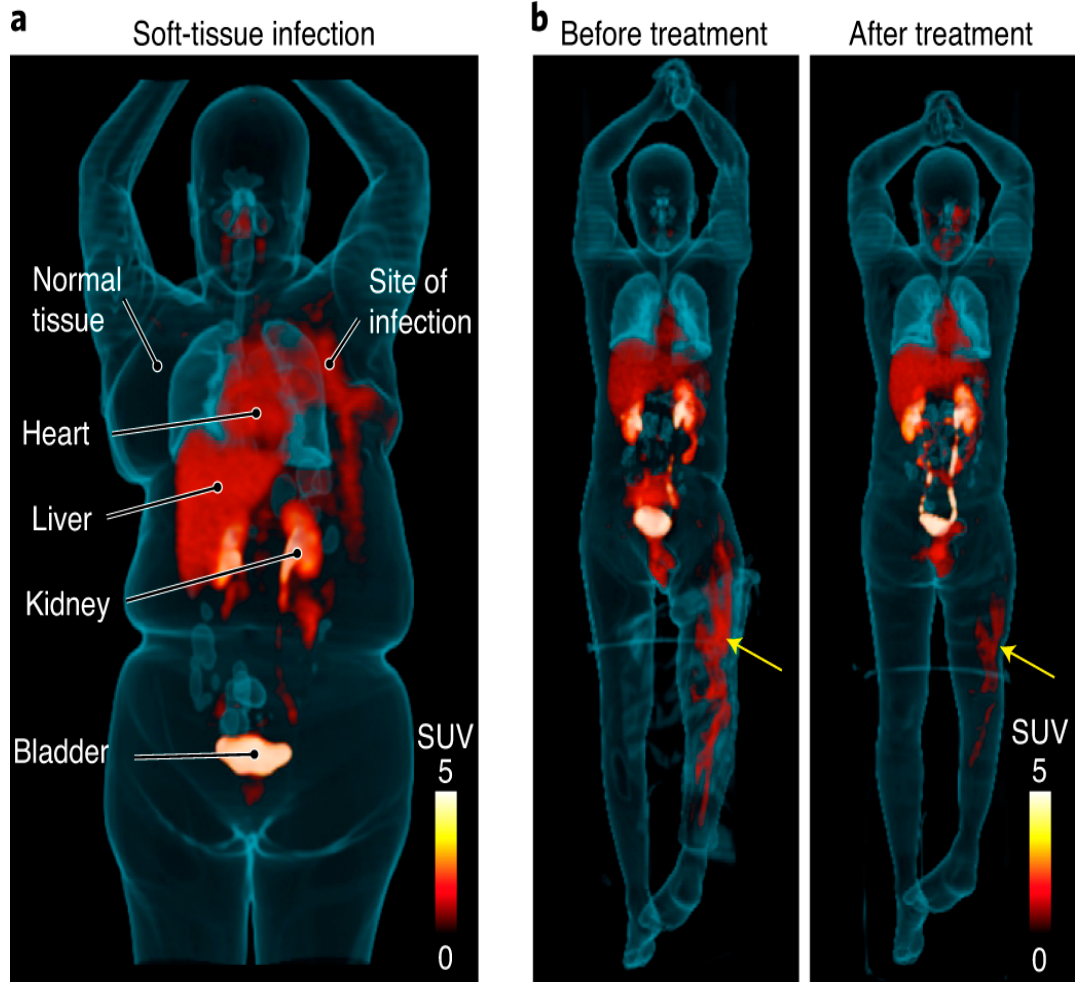
Figure 5. [ 18 F]FDS PET/CT imaging in patients with confirmed Enterobacterales infections. ( a ) Three-dimensional maximum intensity projection (MIP) from a patient with microbiologically confirmed Enterobacter aerogenes cellulitis of the left breast. Signal is also noted in the heart (blood pool), liver, kidneys, and the urinary bladder. ( b ) Three-dimensional MIP from a patient with MDR, extended spectrum beta-lactamase (ESBL)-producing E. coli osteomyelitis before and after inadequate treatment. Yellow arrows indicate site of infection (with permission from [88]).